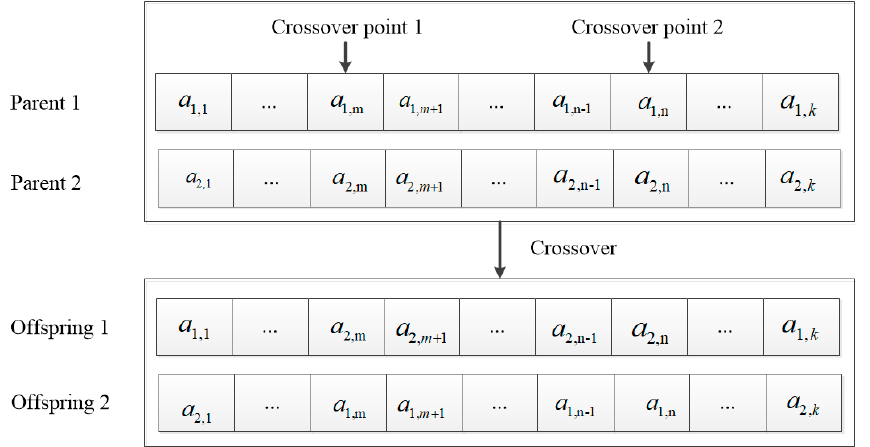
Figure 5. Crossover of the first row of chromosome.